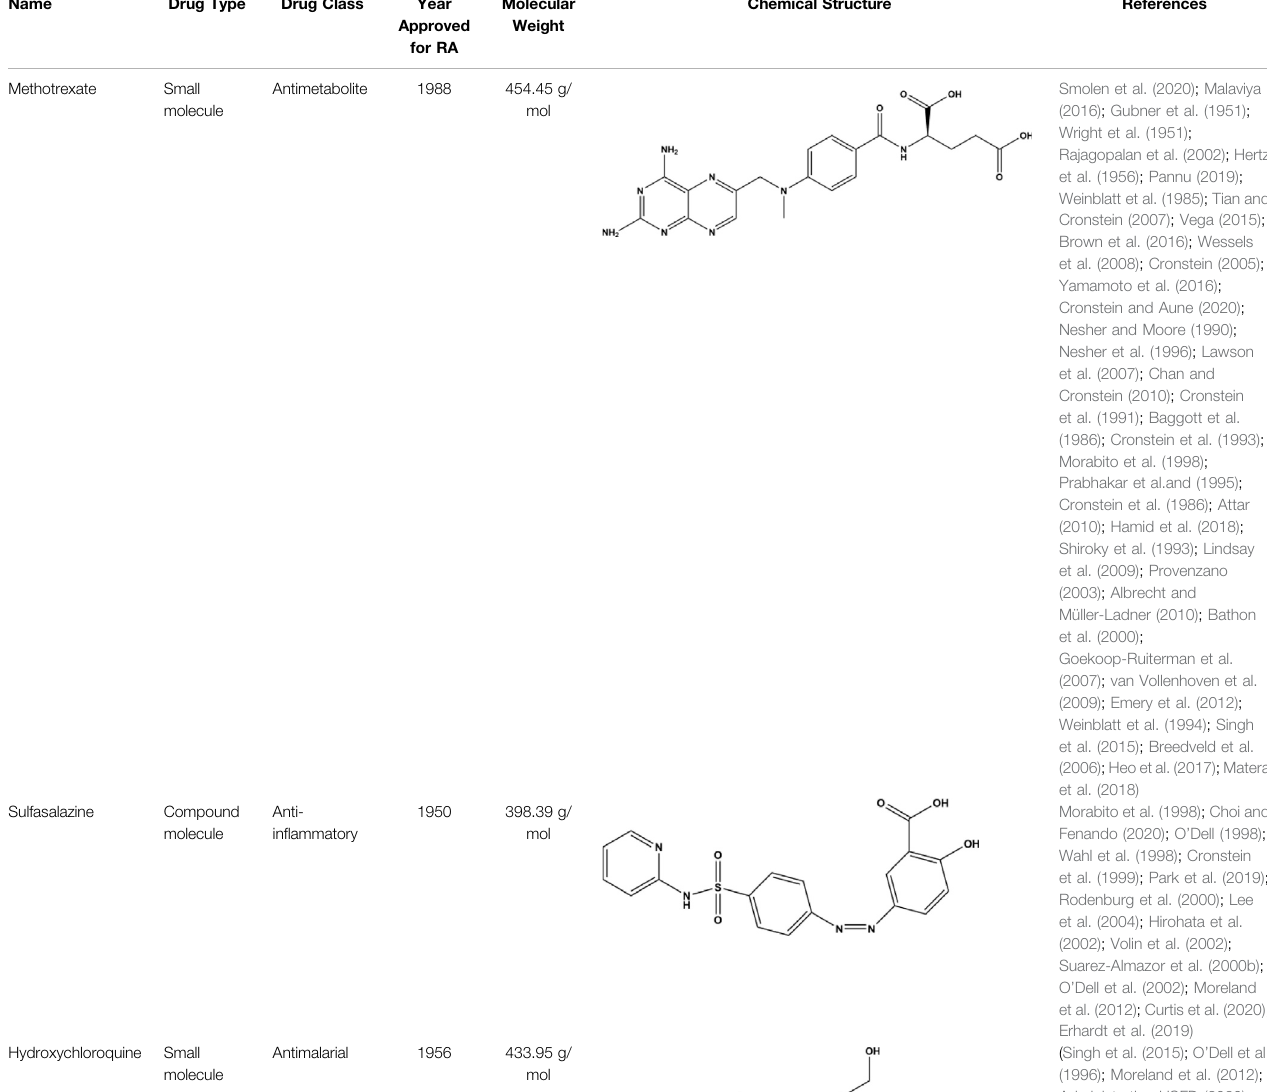
TABLE 1 | FDA approved drugs to treat